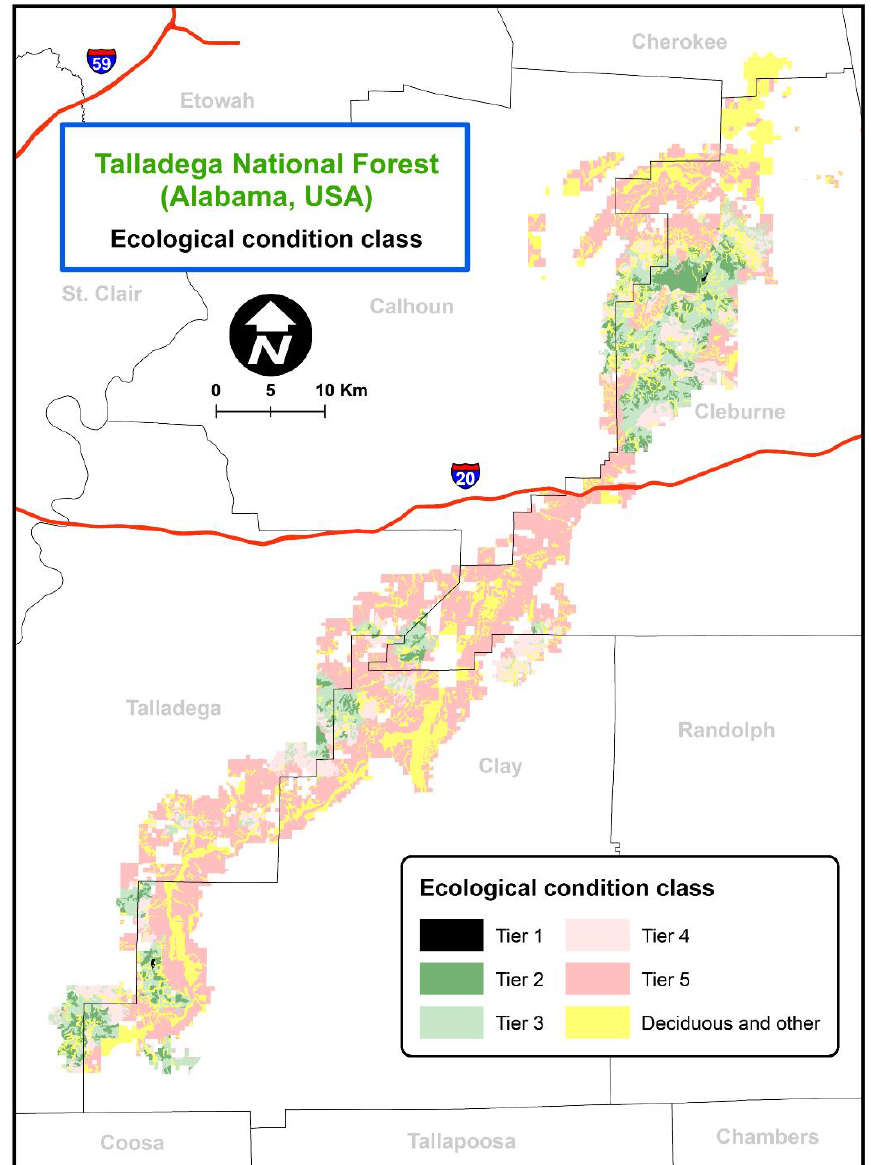
Figure 4. Estimated ecological condition class for a case study on the Talladega National Forest, Alabama, USA.